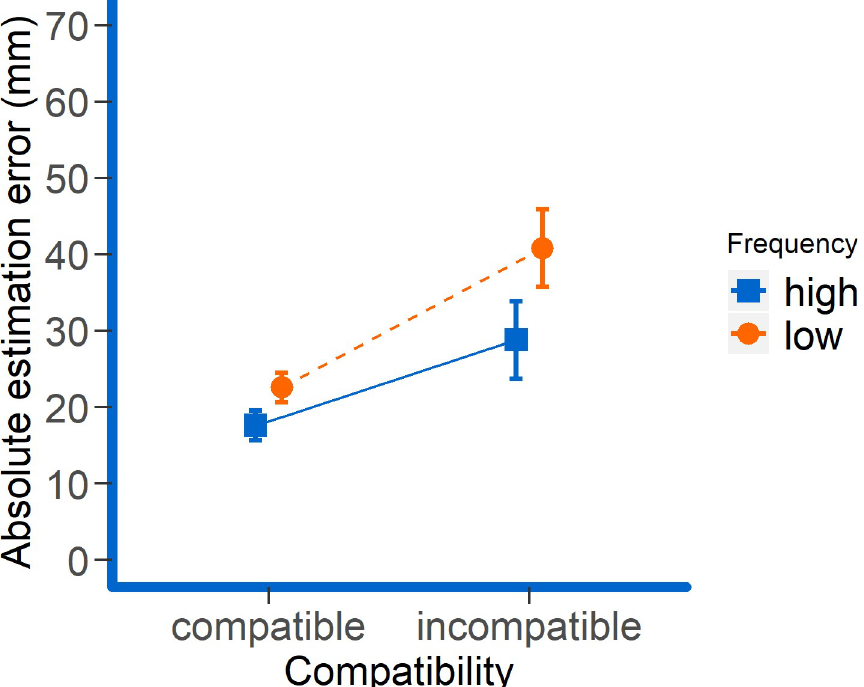
Fig 3. Mean absolute errors as a function of compatibility and frequency of the judgment. Error bars represent 95% paired-difference confidence intervals [26].